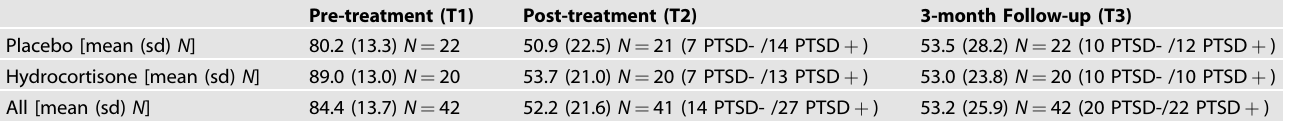
Table 1. CAPS total scores for all subjects in Pre-treatment (T1) and Follow-up (T3). Pre-treatment